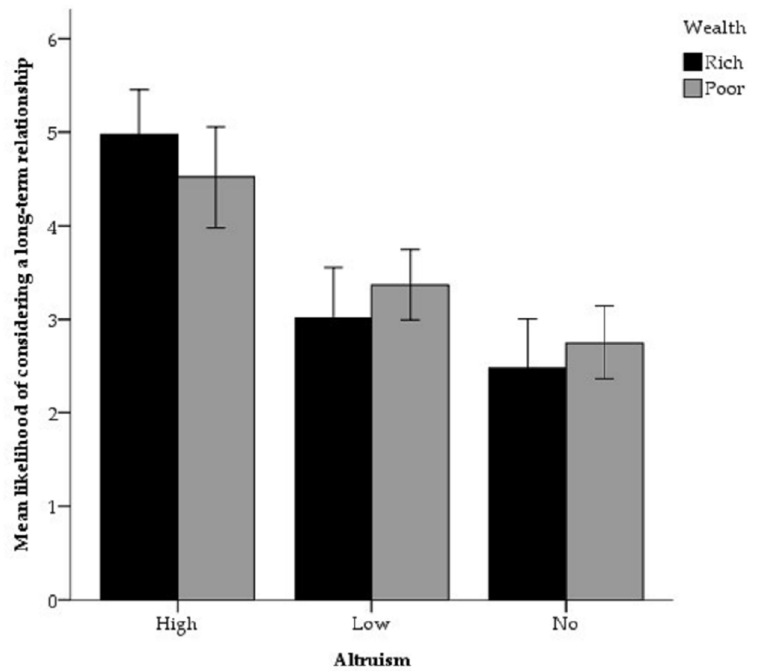
Figure 3. The likelihood that participants would consider having a long-term relationship with the actor in the high-cost, low-cost, and no altruism conditions when he was described as rich and when he was described as poor (error bars represent 95% confidence intervals).